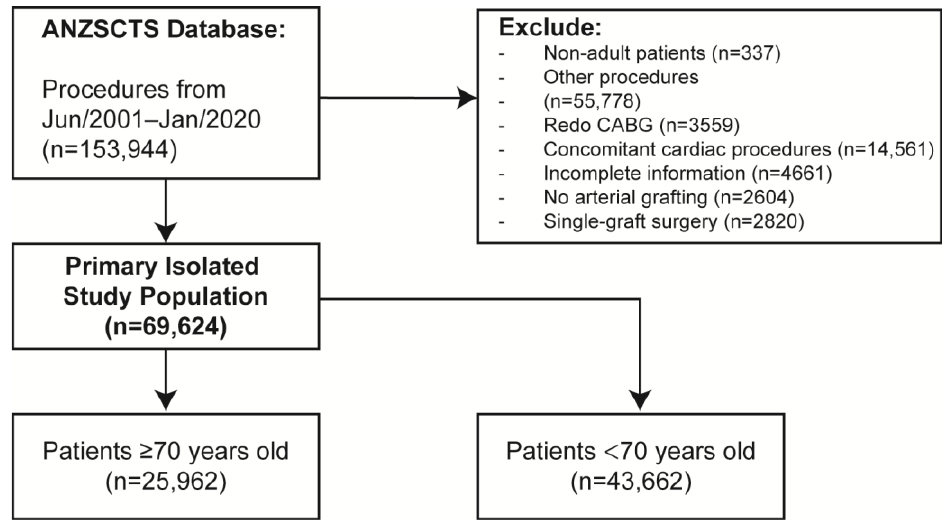
Figure 1. Selection process of eligible patients. ANZSCTS, Australian and New Zealand Society of Cardiac and Thoracic Surgeons; CABG, coronary artery bypass grafting. This flowchart provides information regarding the participant selection process and reasons for exclusions.